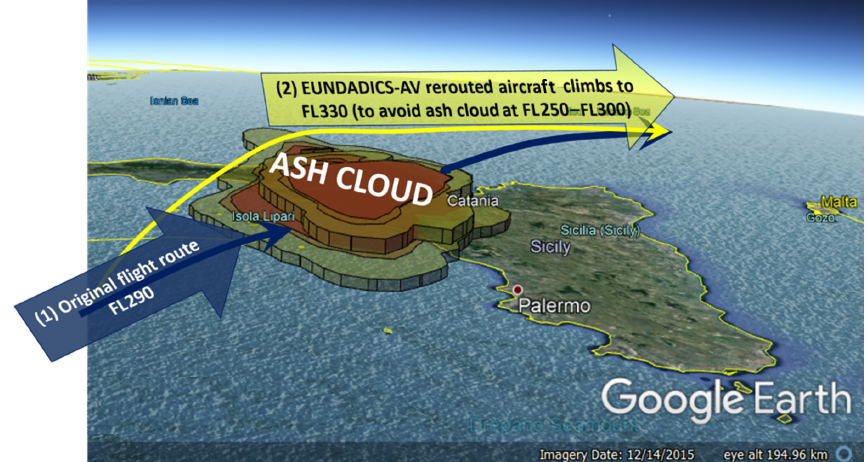
Figure 15. Example of a rerouting of one flight calculated by FLIGHTKEYS and simulated with NAVSIM/USBGSim (University of Salzburg), laterally and vertically avoiding volcanic ash (red ≥ 4mgm − 3 , yellow 2–4mgm − 3 , green 0.2–2mgm − 3 at different flight levels), © Google